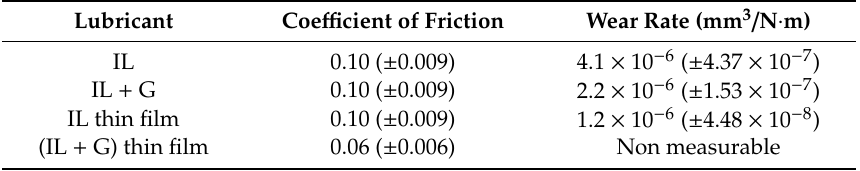
Table 2. Coe ffi cients of friction and wear